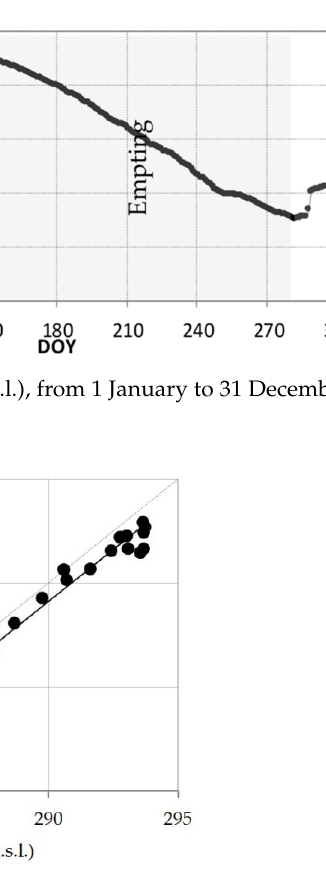
Figure 4. Water levels measured in situ ( H IS ) versus levels obtained by classification ( H RS ) of TOPSAR ascending images.